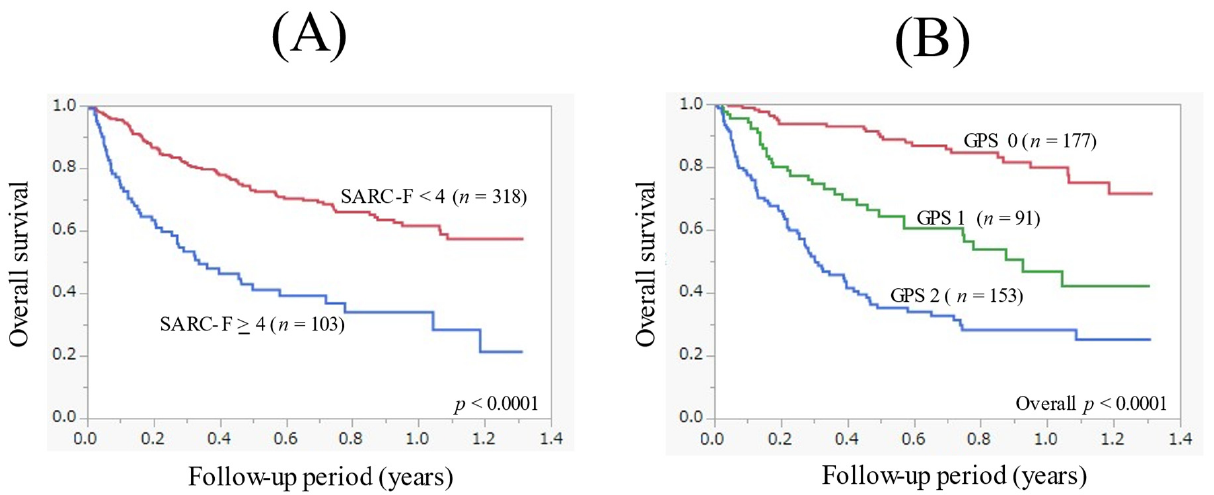
Figure 1. ( A ) Kaplan-Meier curves in patients with the SARC-F score ≥ 4 ( n = 103) and <4 ( n = 318). ( B ) Kaplan-Meier curves in patients with the Glasgow prognostic score (GPS) 0 ( n = 177), GPS 1 ( n = 91), and GPS 2 ( n = 153).